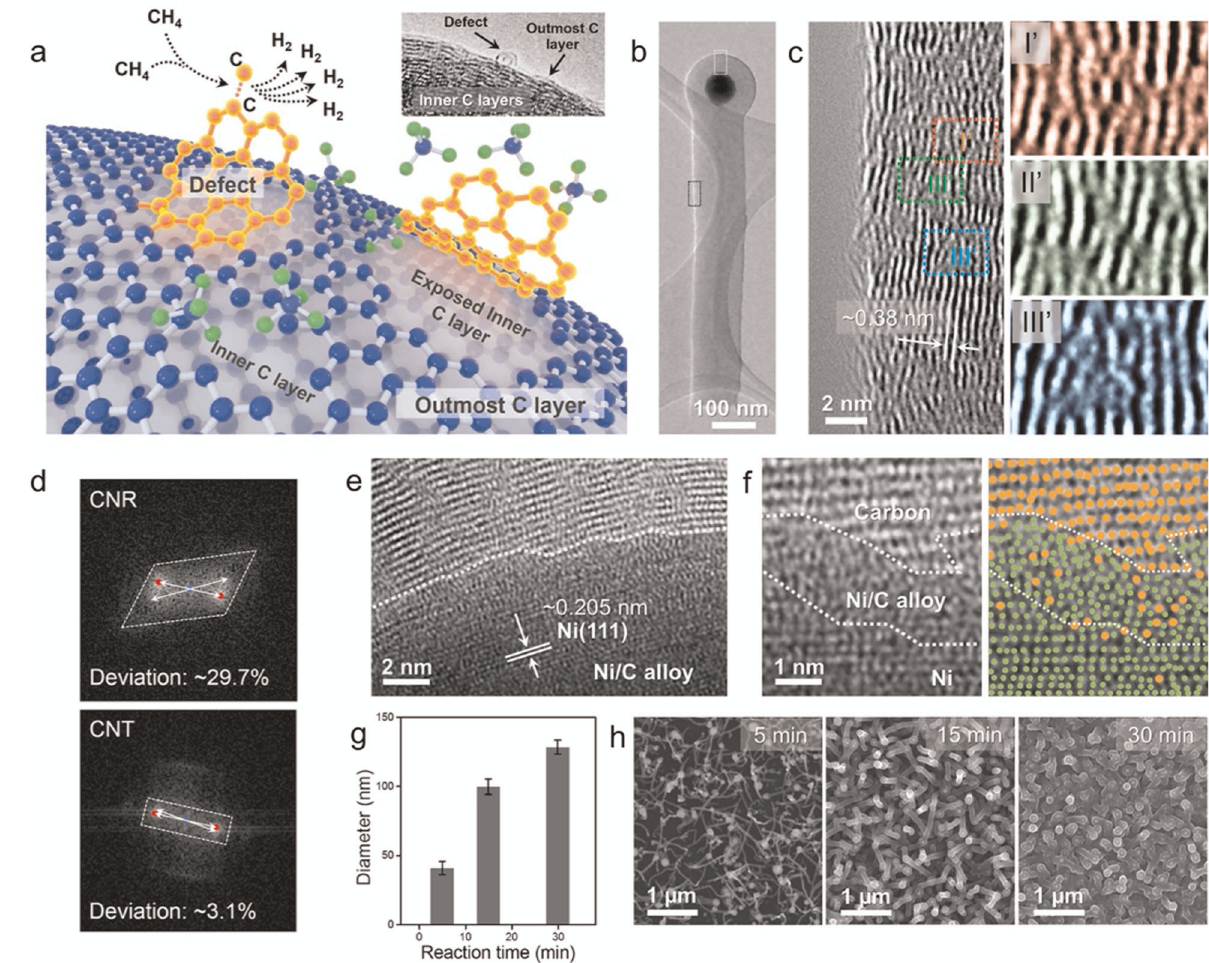
Fig. 3 Growth mechanism and TEM characterization of the individual CNA units. a Schematic illustration for growth mechanism of CNA. Inset: TEM images of CNA observed from the outside interface of individual units, which show the defects at the outmost carbon layers. b Low-magni fi cation TEM image of a single-carbon nanorod shows the Ni catalyst located in the center of one terminal, and fully covered by the carbon layers. c High-resolution TEM images observed from the marked gray square in b. I ’ , II ’ , III ’ are magni fi ed HRTEM images from the marked regions of c , respectively, indicating the discontinuous and crooked carbon layer stacking and the abundant defects. d Fast Fourier transform (FFT) patterns converted from HRTEM images of CNR and CNT indicate that the CNR have larger interlayer spacing deviation than CNT. e , f HRTEM images observed from the interface of the Ni catalyst and carbon layers. Right side of f shows re-structured simulation for the interface of Ni and carbon layers. The carbon layers are parallel to the Ni (111) lattice plane, suggesting that the carbon atoms were separated from alloy along the Ni (111) lattice plane in the growth process. g The diameter of the individual unit of the CNA with the reaction time. h SEM images of the materials synthesized by different reaction